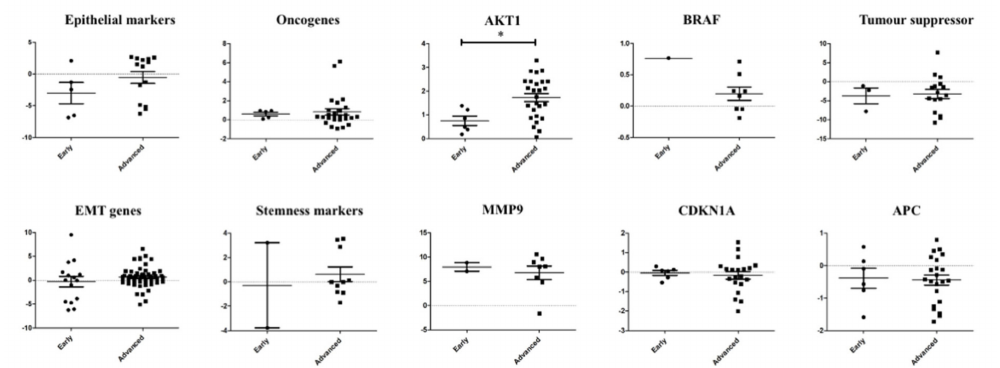
Figure 5. Correlation of the gene expression between single CTCs and pathological stages of colorectal carcinoma. Comparison of the gene expression of the single CTCs in colorectal carcinoma of early and advanced stages showed that only expression of AKT1 was associated with pathological stages of the